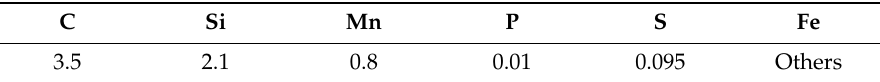
Table 1. Mass percentages of various elements of gray cast iron.